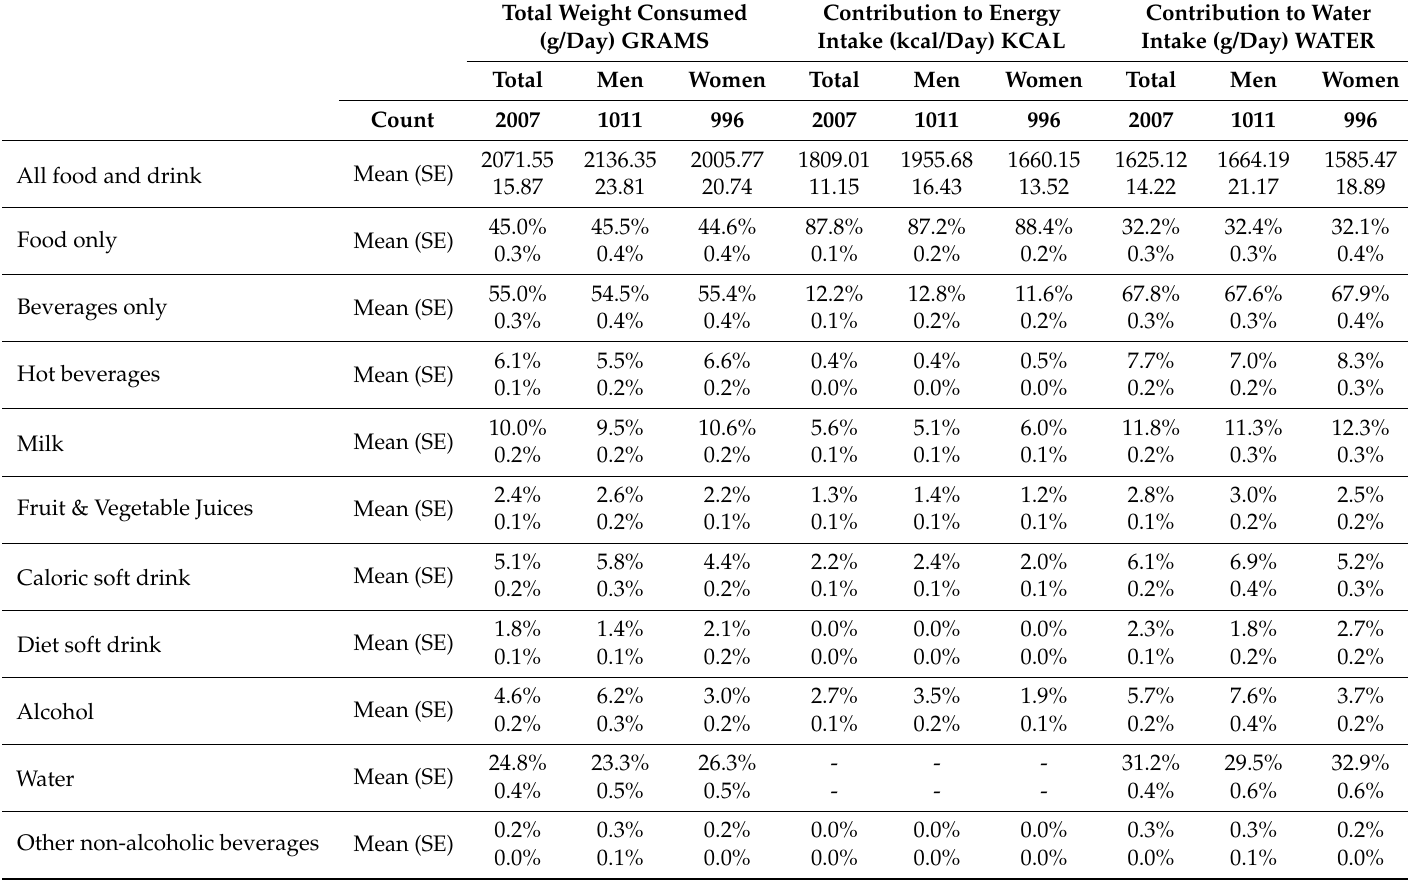
Table 2. Contribution of food and beverages to total water and energy